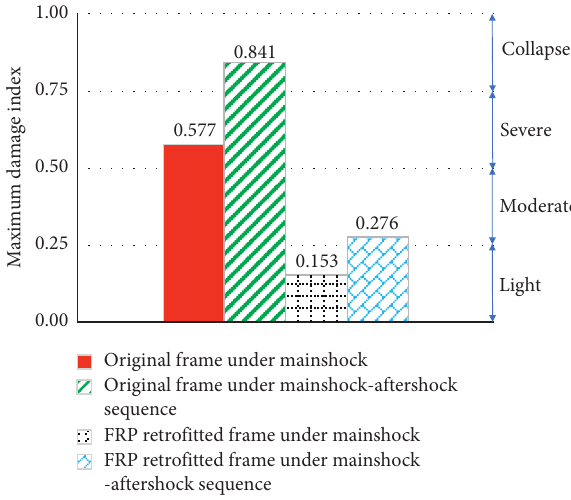
Figure 11: Maximum damage indices of the frames.